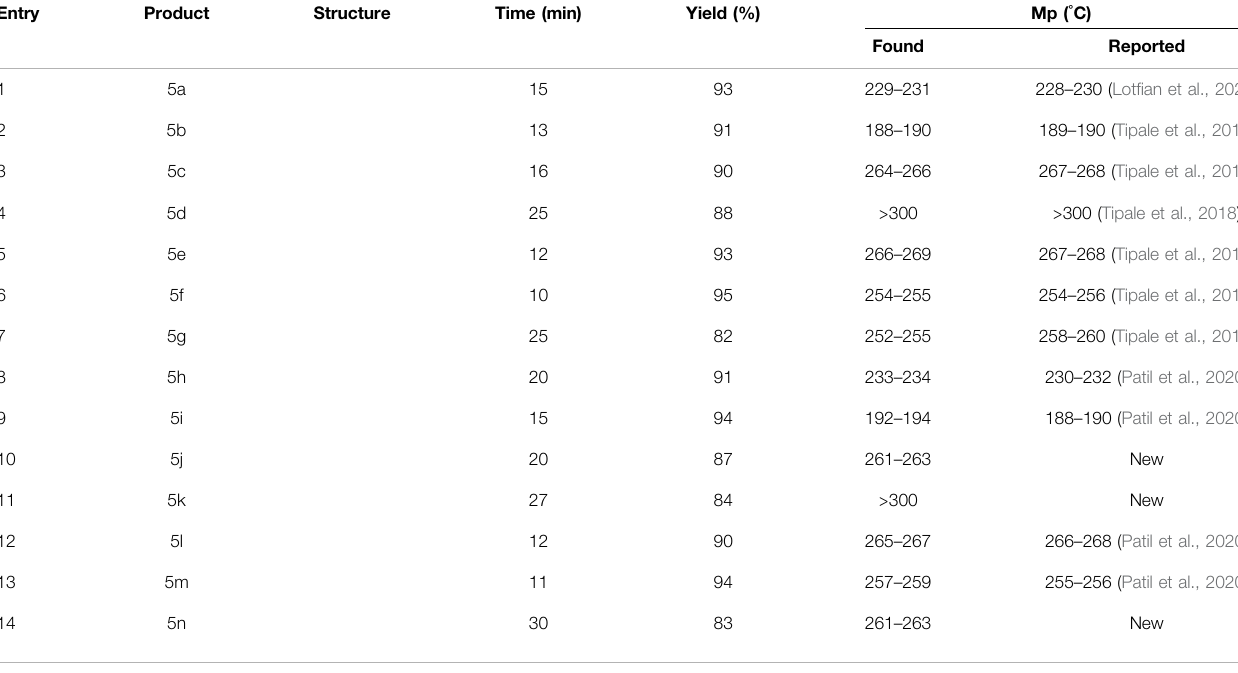
TABLE 3 | Synthesized pyrazolopyranopyrimidine derivatives (5a –